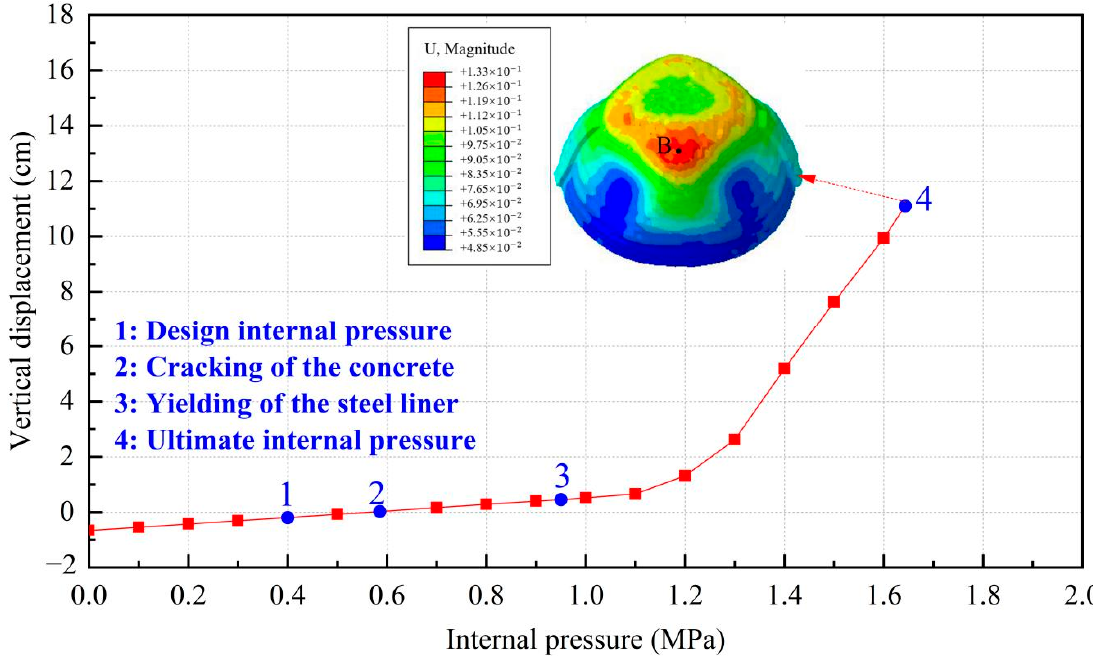
Figure 7. Vertical displacement of the conventional containment (point B).